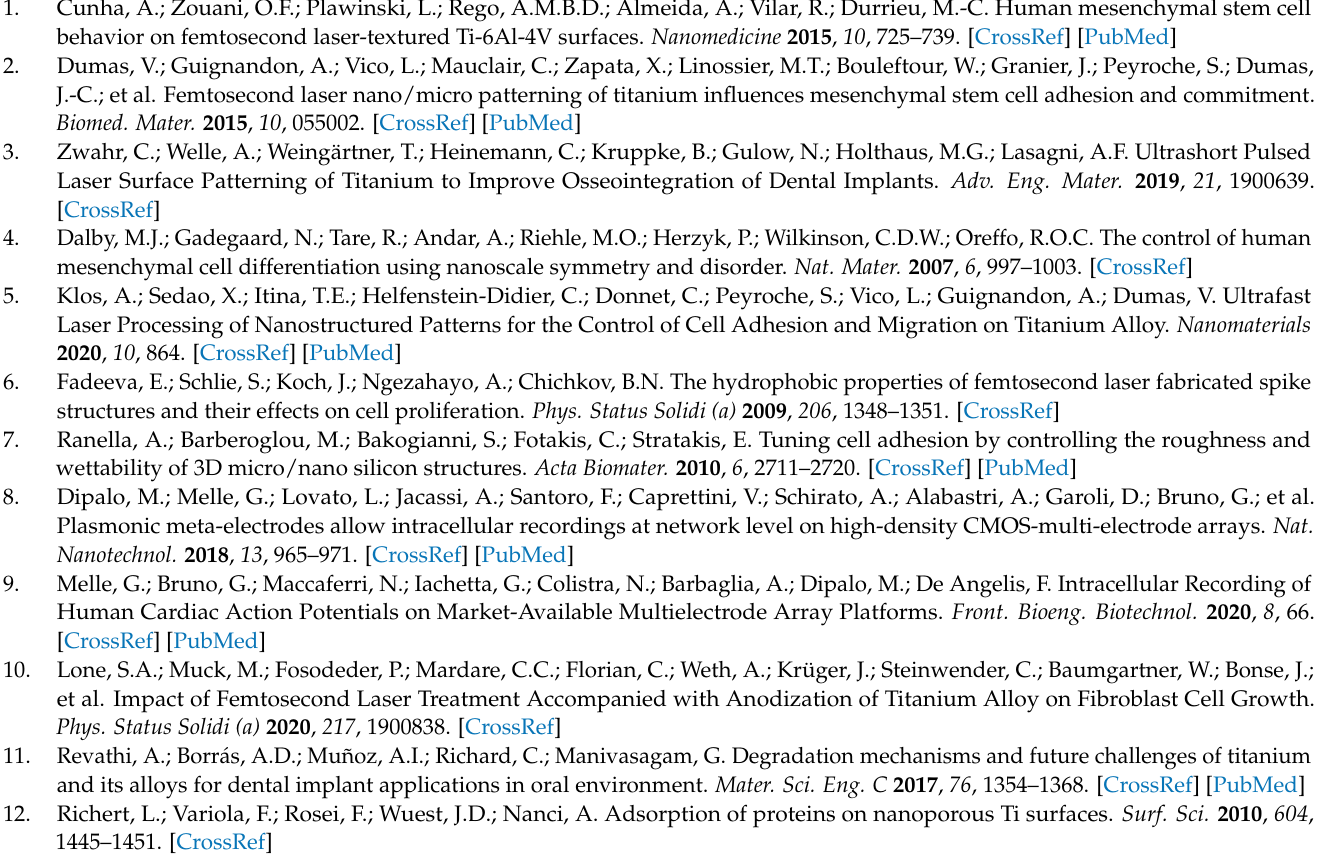
Figure S3: Collagen Type I